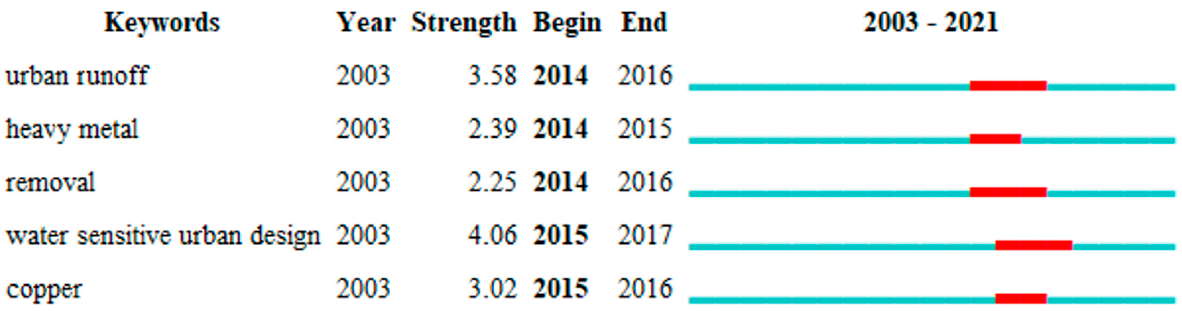
Figure 13. Top five emergent environmental health keywords.